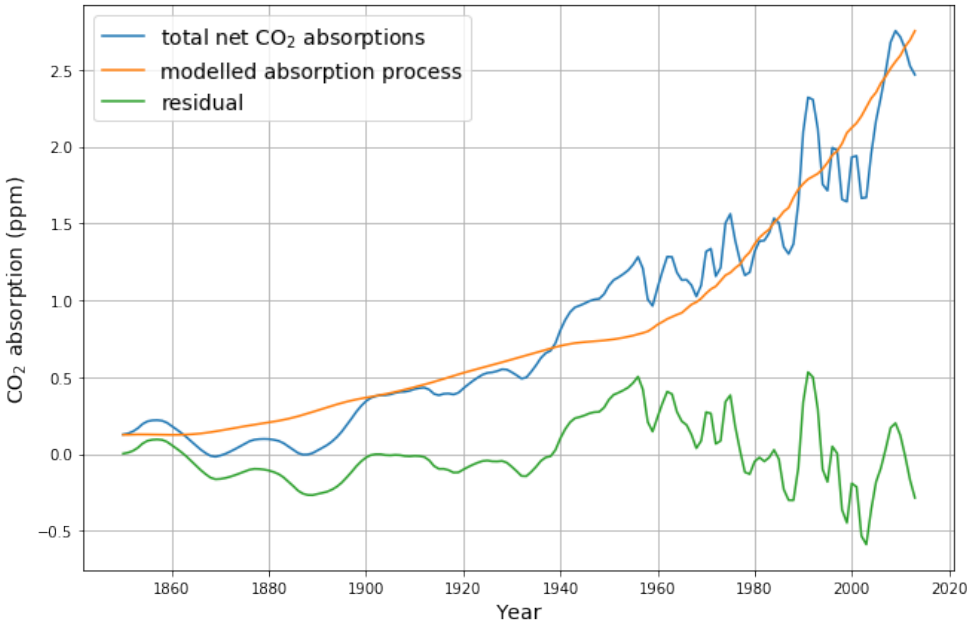
Figure 4. Linear model of CO 2 absorption.